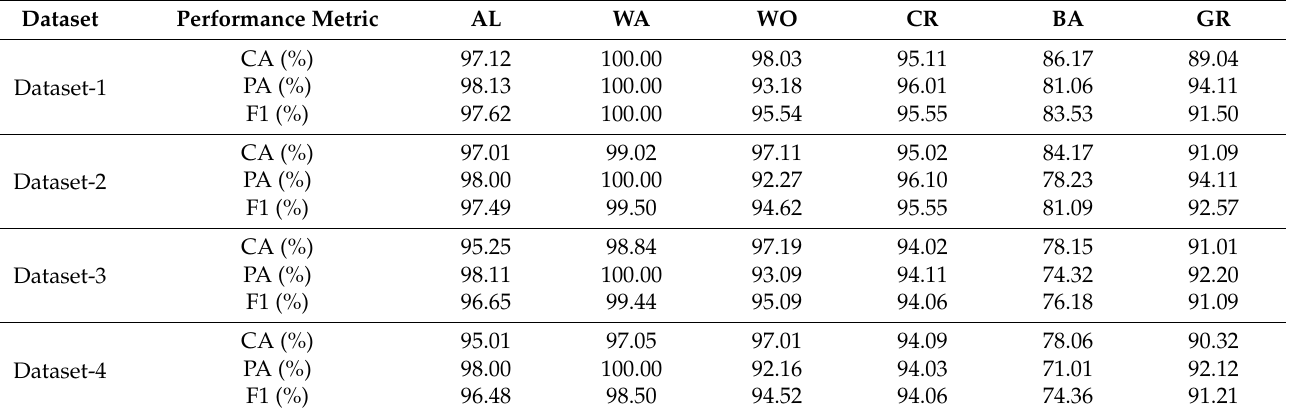
Table 4. Class level accuracy assessment results for all LULC classes (AL: artificial lands, WA: